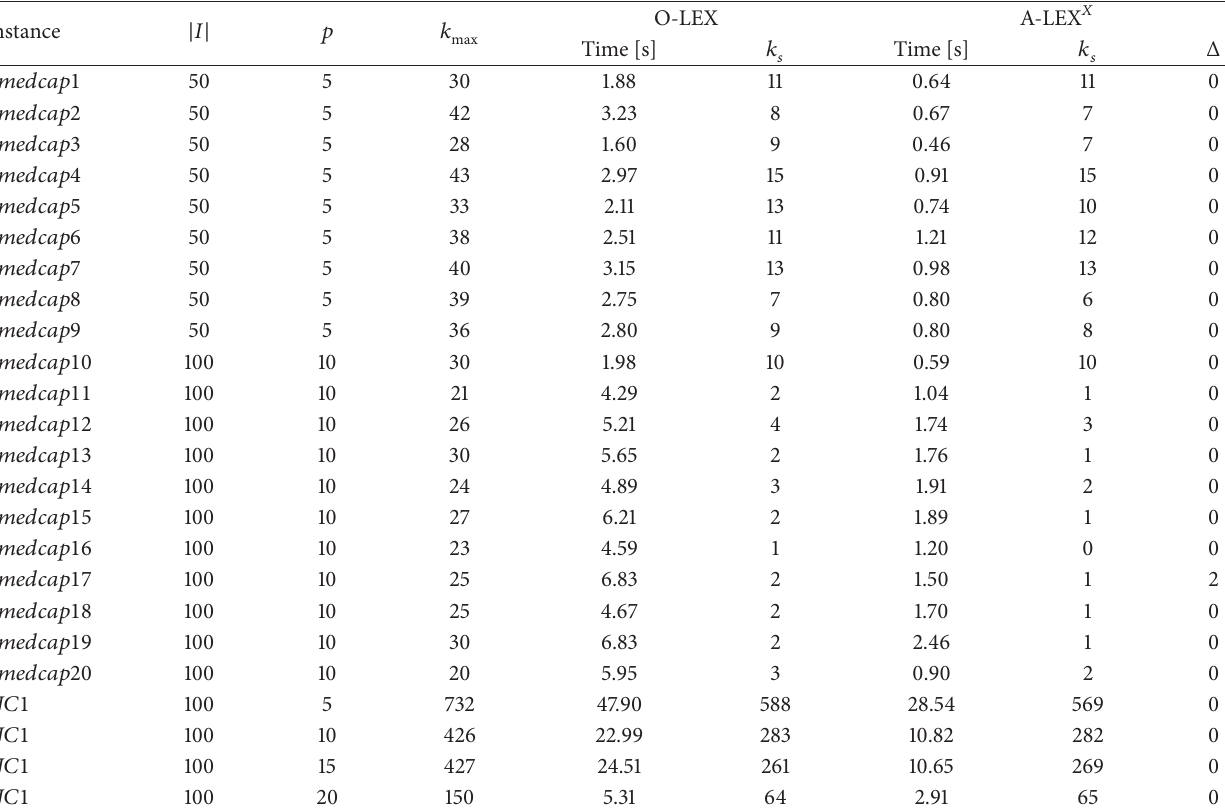
Table 1: Computational results for the algorithm A-LEX: small instances.